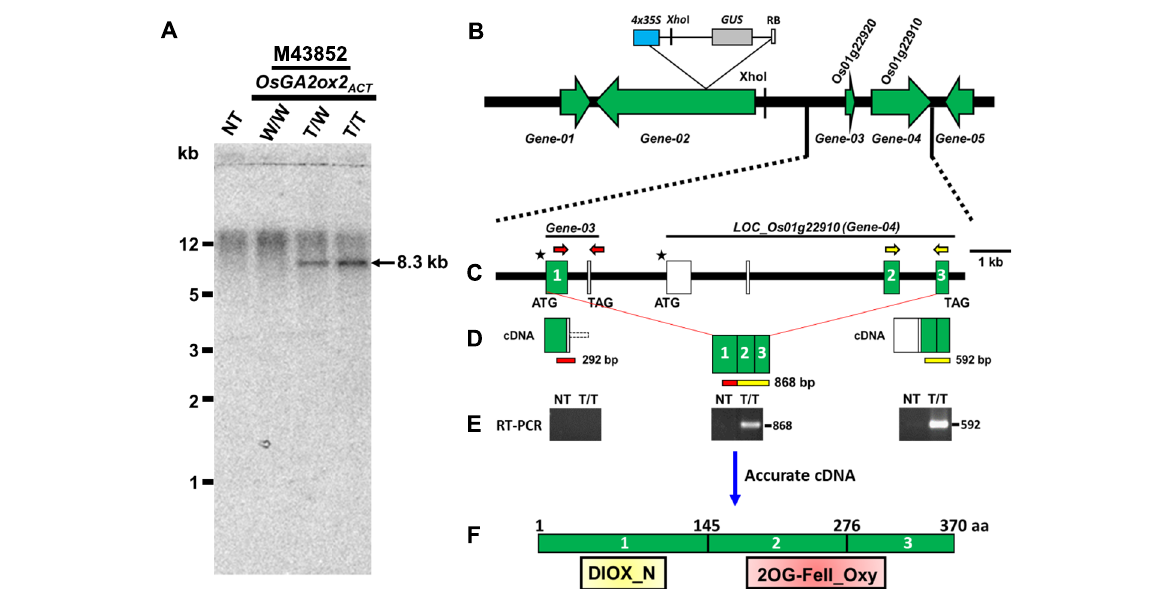
Fig. 2 Southern blot assay of mutant M43852 and a schematic illustration of the RT-PCR results and possible cDNA and exon/intron structures to reannotate the gene structure of OsGA2ox2 . a Southern blot assay showing only one copy of the T-DNA insertion in mutant M43852. b A schematic diagram showing five genes (named gene-01 to gene-05) annotated in a 40 kb region flanking the T-DNA insertion site. c Enlarged regions of annotated gene-03 (LOC_Os01g22920) and gene-04 (LOC_Os01g22910) with their possible exon (box) and intron (bold line) structures. The two primer sets (arrows) utilized to detect gene expression are shown above their genes. d cDNAs and expected sizes of RT-PCR products using the corresponding primer sets for the annotated gene-03, gene-04 and reannotated gene OsGA2ox2 . e RT-PCR results of gene-03 (using the red primer set), gene-04 (using the yellow primer set that amplify 592 bp) and the reannotated gene OsGA2ox2 (using the 5 ′ red and 3 ′ yellow primer sets that amplify 868 bp). f Accurate cDNAs for the reannotated OsGA2ox2. Three exons with 370 amino acids and the relative locations of the DIOX_N and 2OG-FeII_Oxy conserved protein